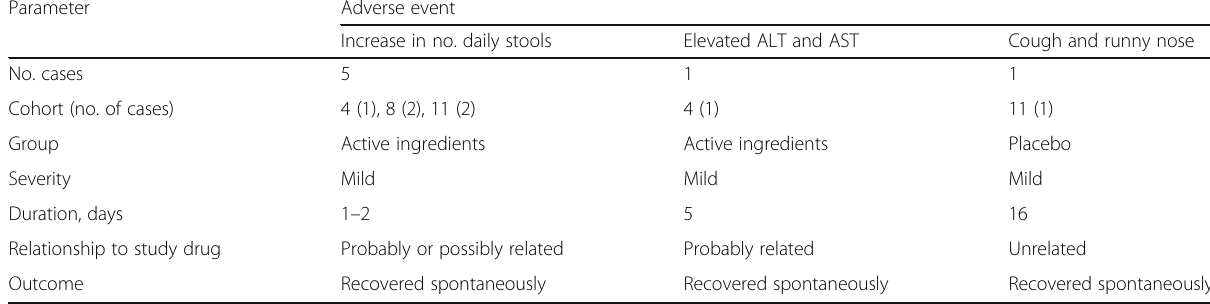
Table 3 Summary of adverse events Parameter